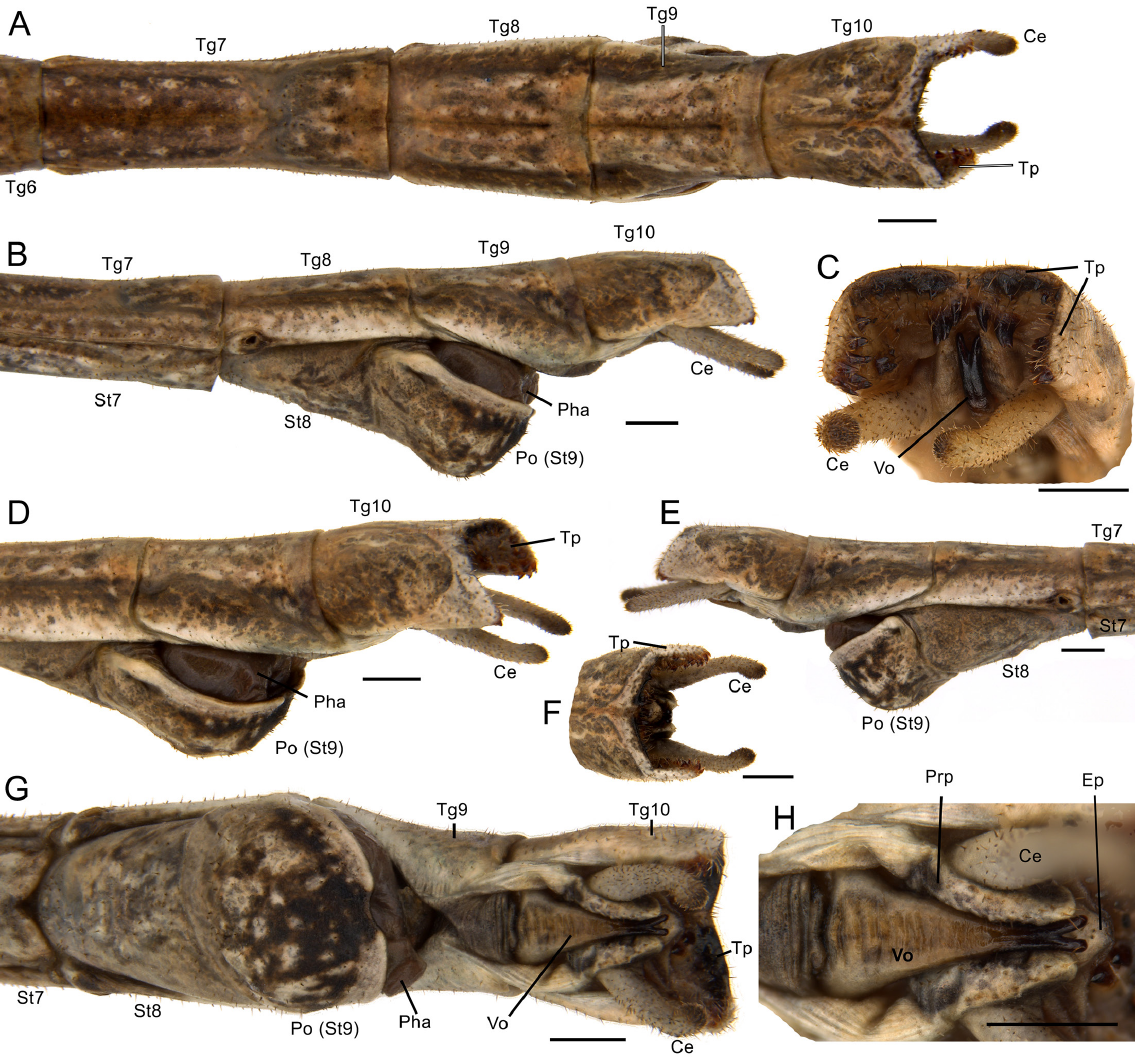
Fig. 40. Arumatia motenata Ghirotto gen. et sp. nov., paratype, ♂ (MZUSP V0602), terminalia morphology. A . Dorsal view. B . Left side lateral view. C . Posterior view, detail of tergum X. D . Left side latero-dorsal view. E . Right side lateral view. F . Posterodorsal view, detail of tergum X. G . Ventral view. H . Detail of vomer, ventral view. Abbreviations: Ce = cercus; Ep = epiproct; Pha = phallic organ; Po = poculum; Prp = paraproct; St = sternum; Tg = tergum; Tp = thorn pads; Vo = vomer. Scale bars: 0.5